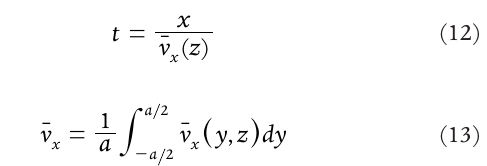
= 837 J kg −1 K −1 , K = 3 W K −1 m −1 , q = 10 4 W m −2 , x = 8100 Pa, b =170). x ´ is the p 0 0